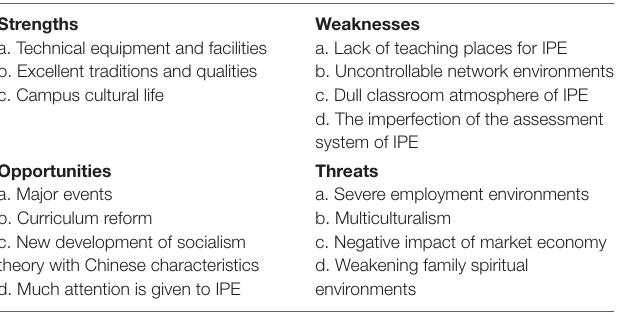
Frontiers in Psychology |